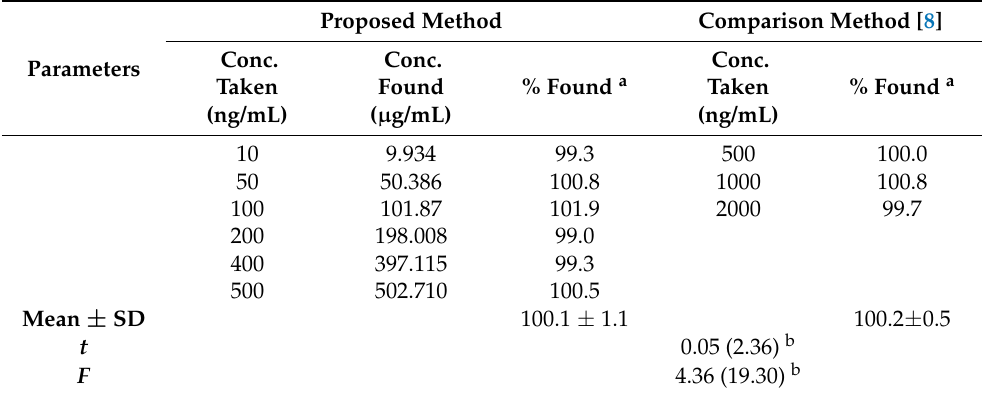
Table 2. Application of the presented spectrofluorimetric method for NFZ determination in pure form and statistical comparison with the obtained results adopting the reported HPLC method.